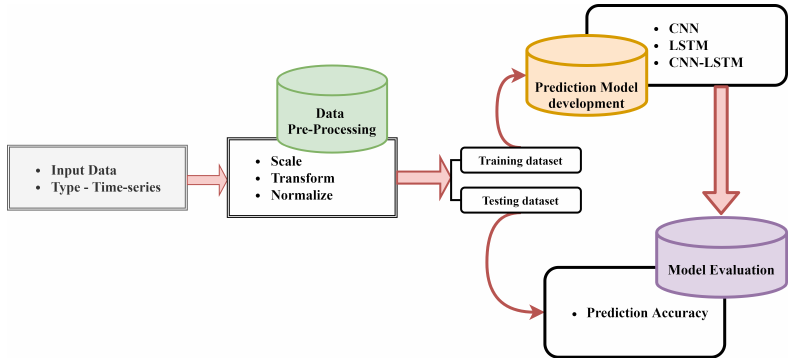
Figure 2. The overall architecture of the proposed predictive maintenance